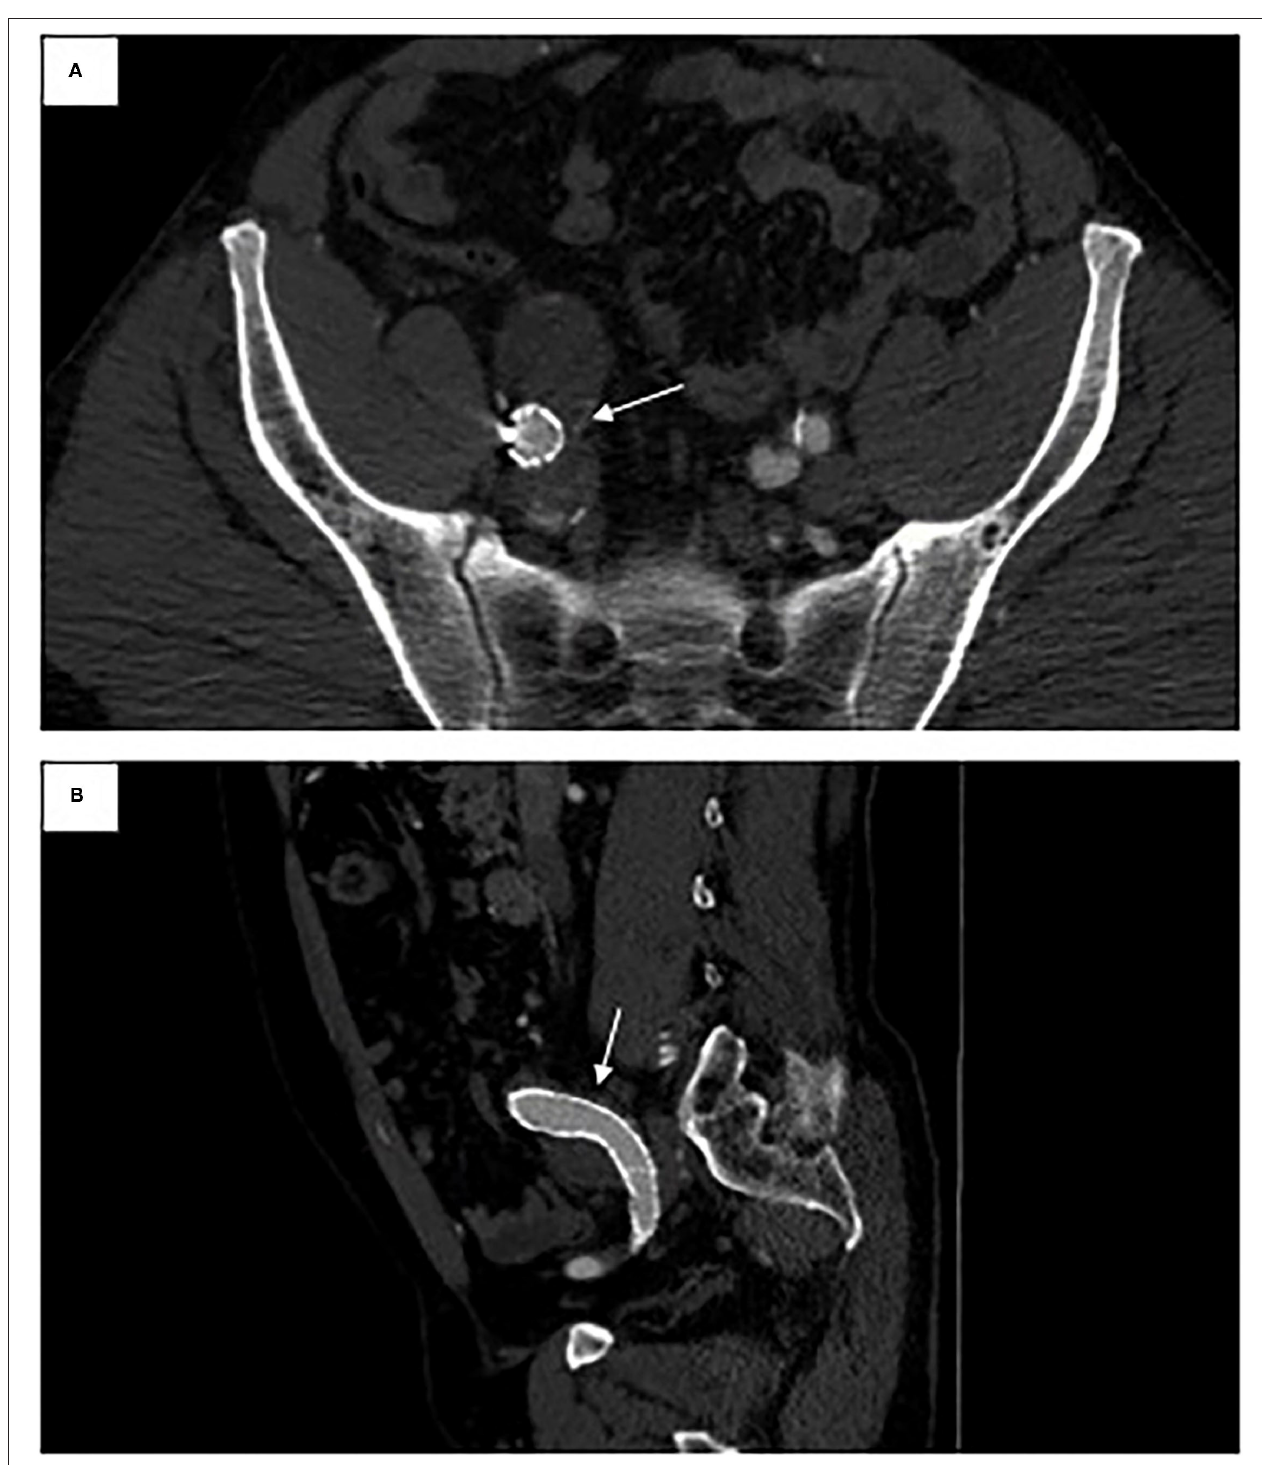
FIGURE 4 | One-year follow-up CT angiogram. (A) Axial view of right iliac limb in previous fistula location. (B) Sagittal view of right iliac limb in previous fistula location. direct sympathetic effects and stimulates renal renin